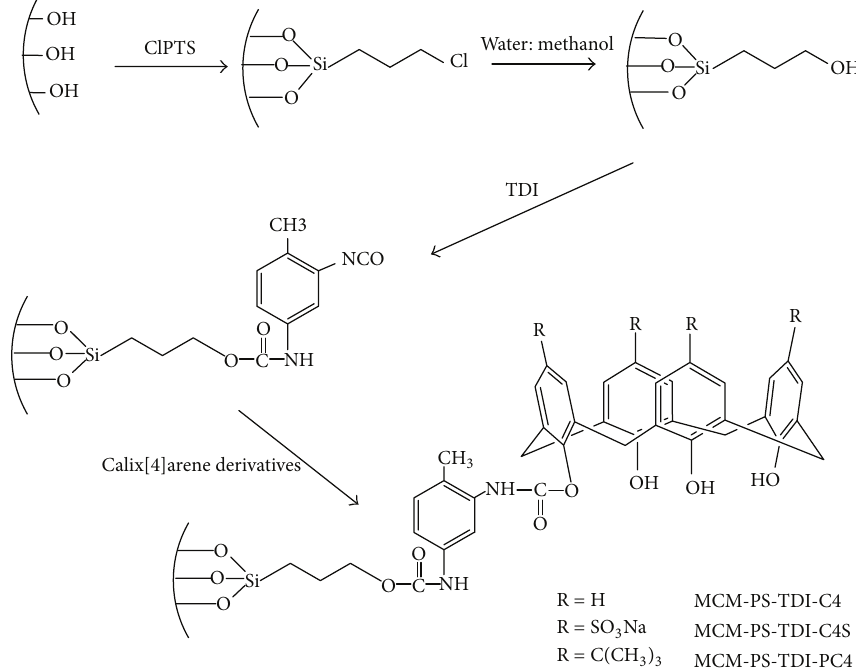
Figure 1: Preparation of modified mesoporous silica with calix [4] arene derivatives.